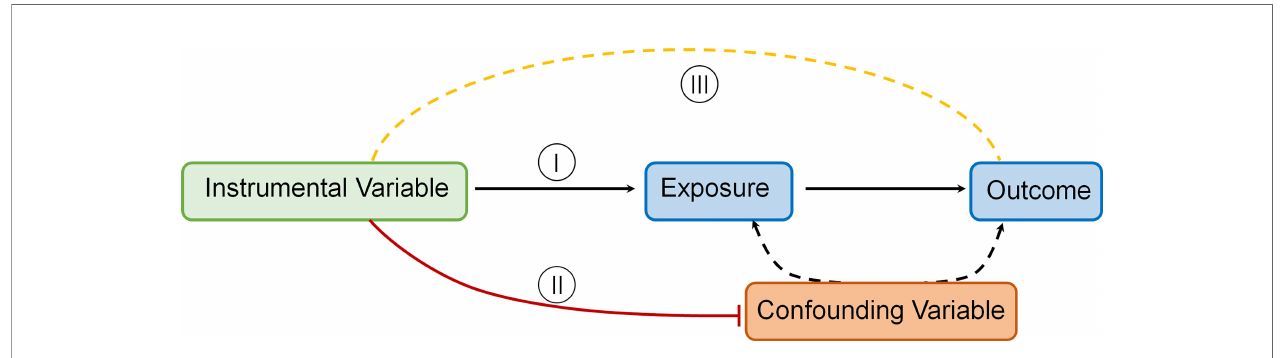
FIGURE 1 | Directed acyclic graph depicting MR principles and underlying IV assumptions (I